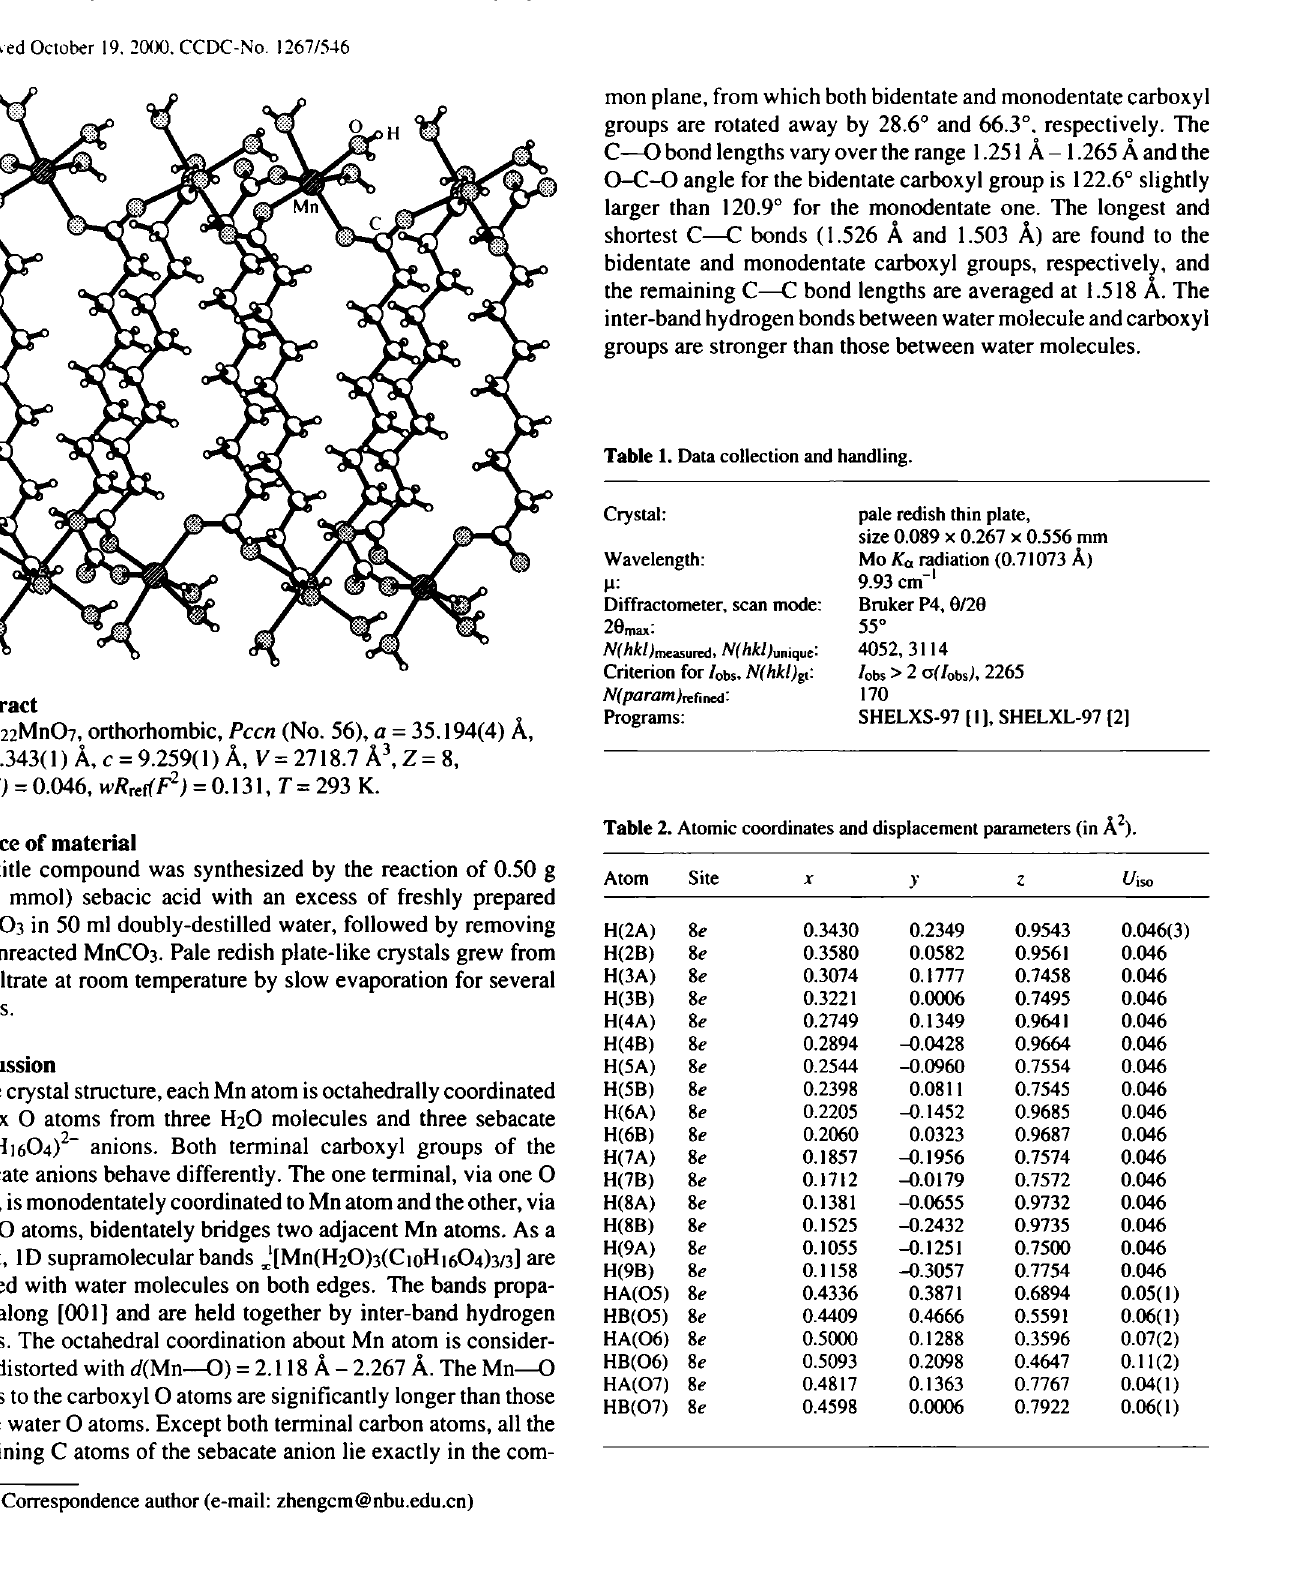
Table 1. Data collection and handling.